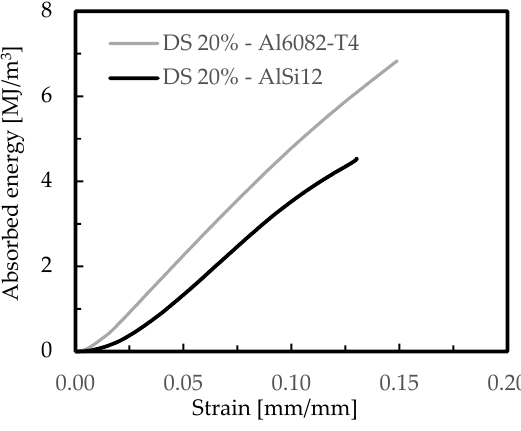
Figure 10. Absorbed energy-strain curves for foam-filled tubes. Table 6. Results for foam-filled tubes with a relative density of 20%.